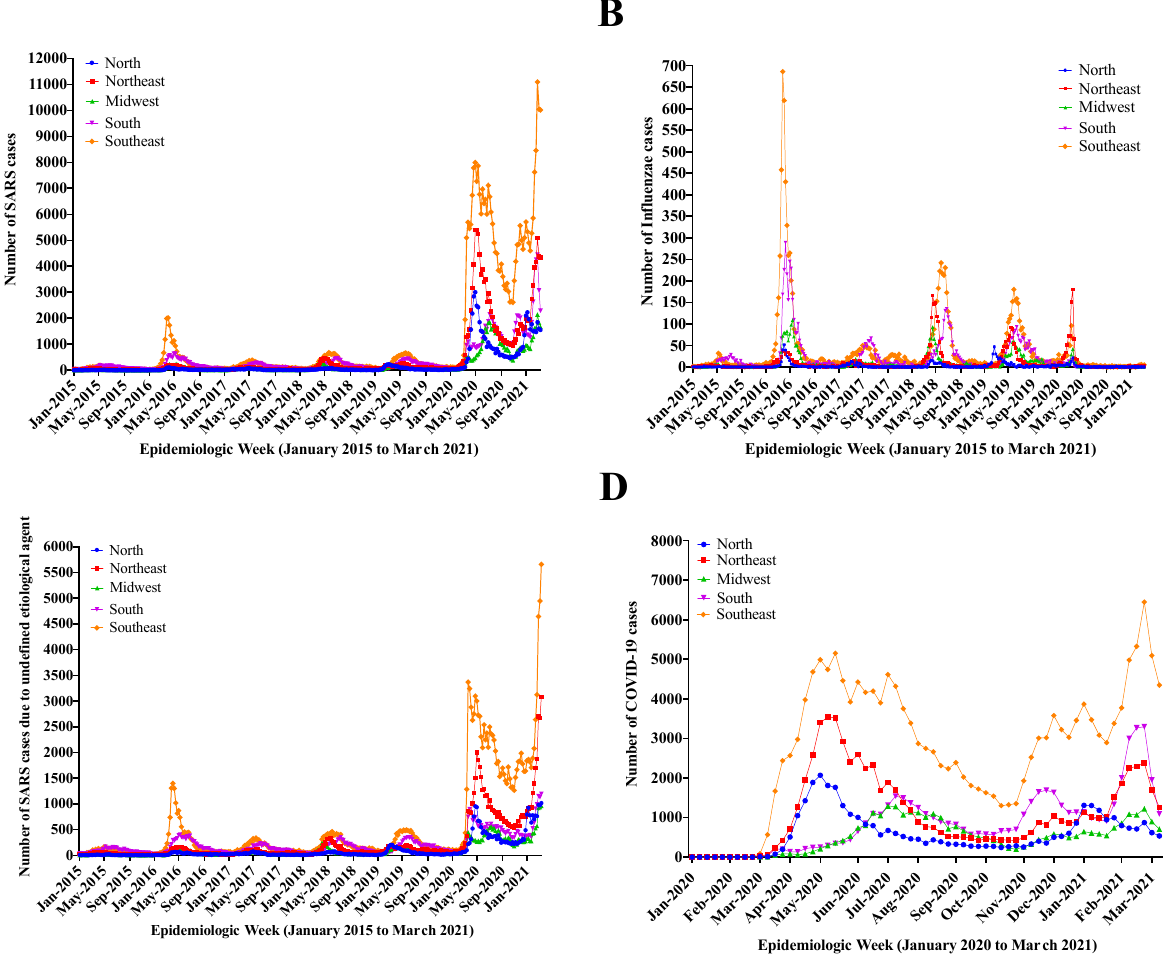
Figure 1. Severe Acute Respiratory Syndrome (SARS) overview in Brazil during the study period (January 2015 to March 2021). ( A ) SARS cases regardless of the etiological factor. ( B ) Evolution in the number of SARS cases resulting from Influenzae. ( C ) Evolution in the number of SARS cases with undefined etiological agent. ( D ) Evolution in the number of Coronavirus Disease (COVID-19) cases in 2020–2021.The data presented in this figure demonstrate SARS evolution according to Brazilian geopolitical regions. In Figure 1A–C, the description of the epidemiological weeks from Jan 2015 to Mar 2021 is observed. In Figure 1D, epidemiological weeks from Jan 2020 to Mar 2021 are